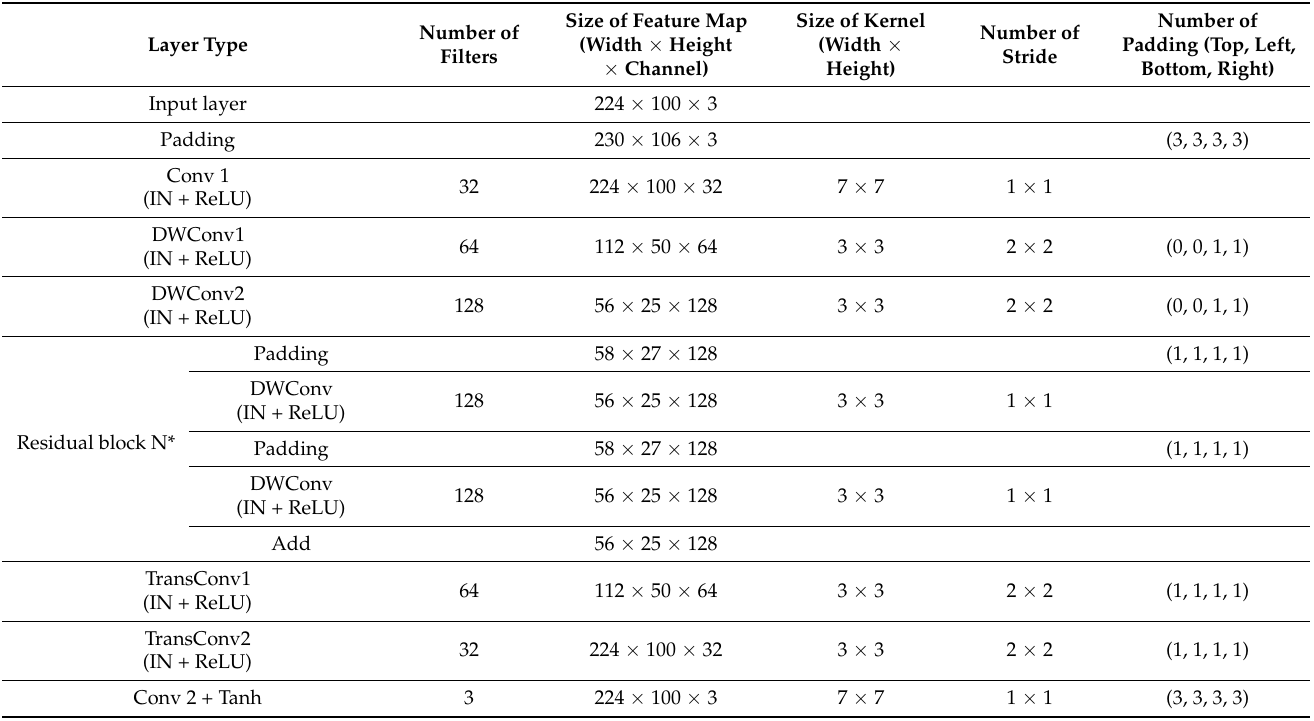
Figure 4. Description of the attention-guided generator of SI-AGAN. Table 5. Architecture of the attention-guided generator. (Conv, DWConv, IN, ReLU, TransConv, and Tanh each refer to convolution layer, depthwise separable convolution layer, instance normalization, rectified linear unit, transposed convolution, and hyperbolic tangent, respectively; N* indicates a number from 1 to